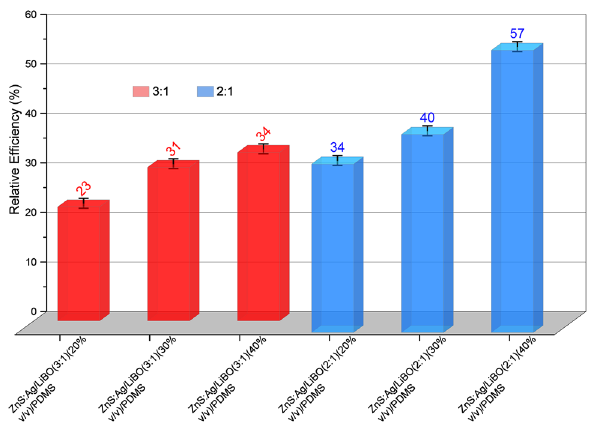
Figure 7. Thermal neutron relative efficiencies of the ZnS:Ag/LiBO-based detectors with respect to the EJ-420 detector.